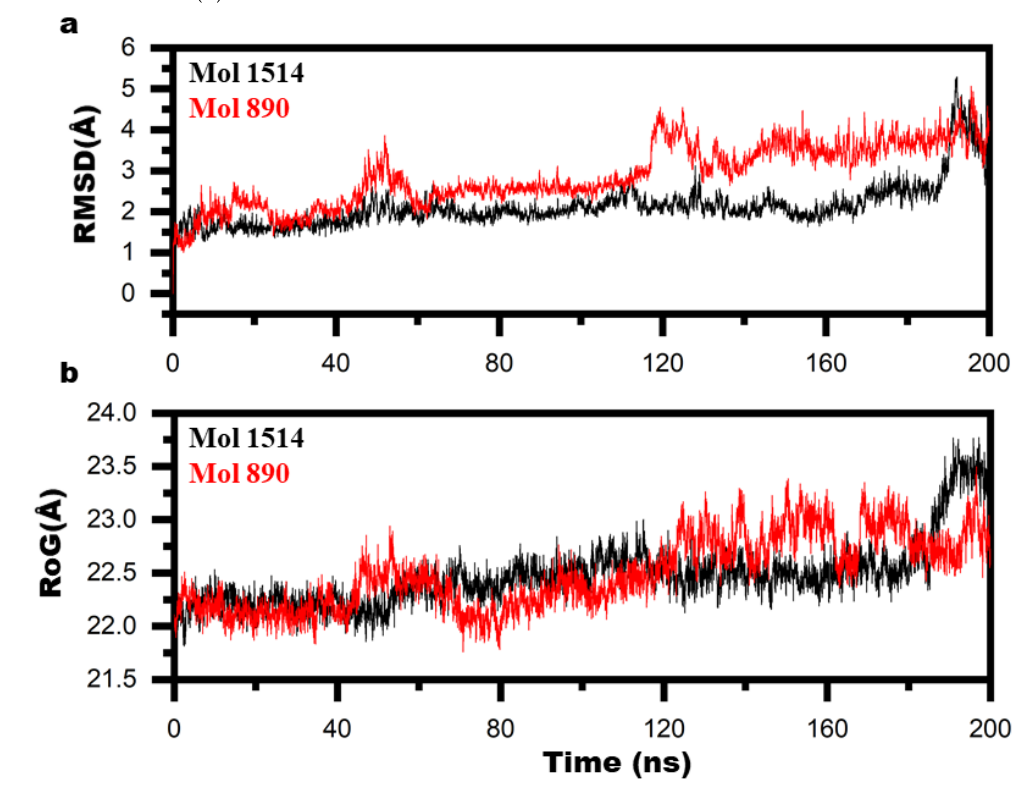
Figure 8. Dynamis stability of the top 2 molecules screened with smina: ( a ) RMSD, ( b ) RoG.